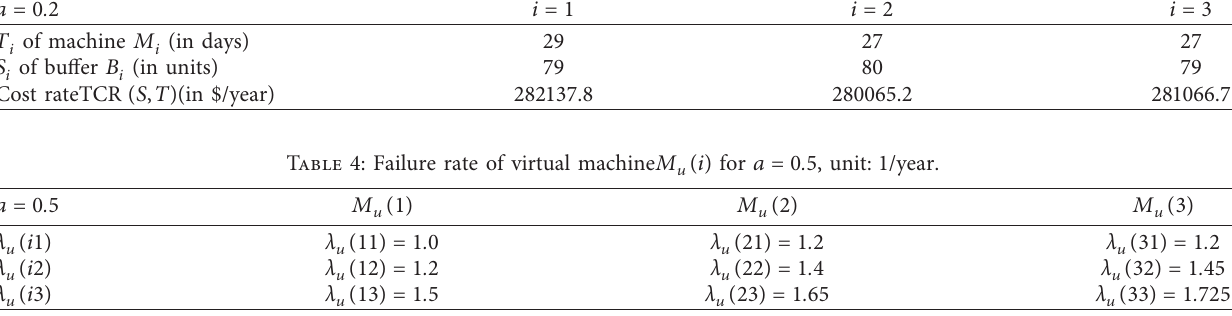
Figure 9: Diagram of the cost rate (in $/year) of machines M units). Table 3: The lowest cost rate with the optimal monitoring time of the machine of the intelligent series system and the optimal buffer stock for a � 0 . 2